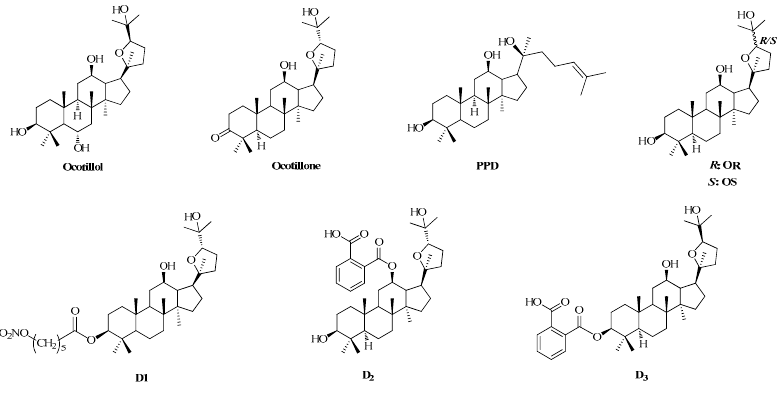
Figure 1. The structures of ocotillol and analogs.